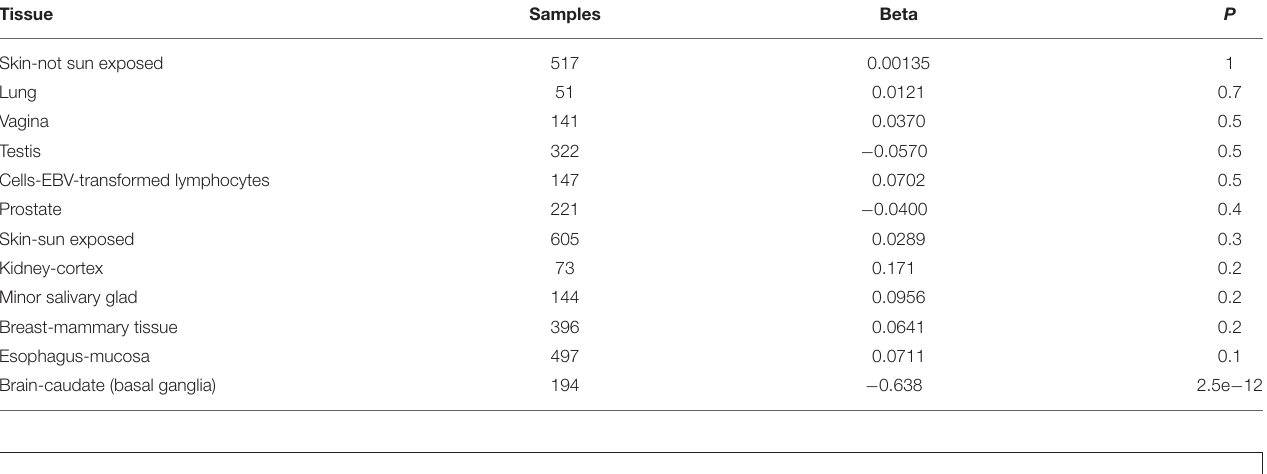
TABLE 3 | rs752107 variant and WNT3A expression in 12 human tissues.